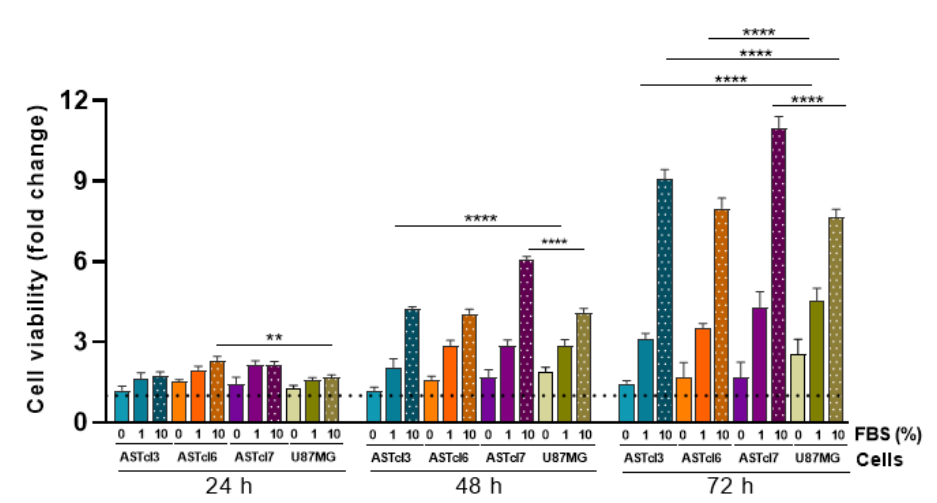
Figure 3. Astrocyte-derived clones acquired the capability to survive under serum starvation, similar to U87MG GBM cells. Graph showing cell viability in the absence or presence of fetal bovine serum (FBS) (1% and 10%) at 24, 48, and 72 h. Bars represent the means ± standard deviations of the fold change relative to the control at time zero. Statistically significant differences between the clones (ASTcl3, ASTcl6, and ASTcl7) in each condition (0, 1 and 10% FBS), compared to U87MG GBM cells, are represented by asterisks: ** p = 0.01, **** p < 0.0001. The ability of ASTcl3, ASTcl6, and ASTcl7 cells to form colonies in anchorage ‐ inde ‐ pendent growth was analyzed by a soft agar colony formation assay, widely used to eval ‐ uate cellular transformation in vitro. There was variability in the number (Figure 4A, p < 0.0001 for all paired ‐ comparisons) and size (Figure 4B) of colonies formed in the anchor ‐ age ‐ independent growth, where clone ASTcl7 formed larger colonies, but fewer in num ‐ ber, while ASTcl6 formed a higher number of colonies (Figure 4B). This assay confirmed the potential tumorigenic capacity of the clones. Additionally, cell migration analysis of primary astrocytes, as well as ASTcl3, ASTcl6, and ASTcl7 clones, was performed by the monolayer wound ‐ healing assay. All three clones displayed greater migratory activity compared to the primary astrocytes after 24 h ( p < 0.01, for ASTcl3 and ASTcl5, and p < 0.001, for ASTcl7). After 48 h, the scratches had completely closed for all clones ( p < 0.0001 for all clones compared to controls), but not for the primary astrocytes (Figure 4D).